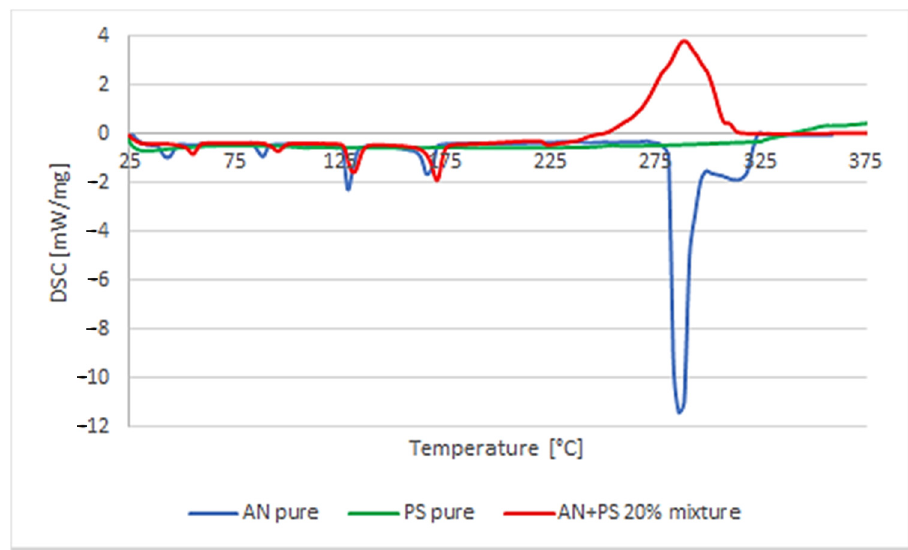
Figure 6. DSC analysis of pure AN, pure polystyrene (PS), and their mixture (20%), heat rate 10 °C/min.